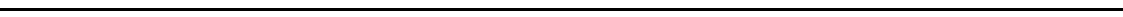
Fig. 1 Enhanced trapping of MT4-MMP-null peritoneal macrophages due to increased α M integrin (Itgam) levels and activity. a Representative fl ow cytometry dot plots and histograms of mouse peritoneal macrophages stained for CD45, Itgam, and F4/80 in basal conditions (left) and 72 h after thioglycollate (TG) injection (right). b Number of macrophages (Itgam + F4/80 + ) collected in the peritoneal eluate of wild-type and MT4-MMP-null mice at the indicated times after TG injection; n = 3 mice in basal and n = 12 mice at 72 h per genotype in one in basal and four in 72 h independent experiments, respectively. c Representative confocal microscopy images (left) and quanti fi cation (right) of monocytes/macrophages (Itgam + ) in the peritoneal membrane 72 h after TG injection; n = 6 mice per genotype in two independent experiments; scale bar, 50 µ m. d Flow cytometry analysis of Itgam